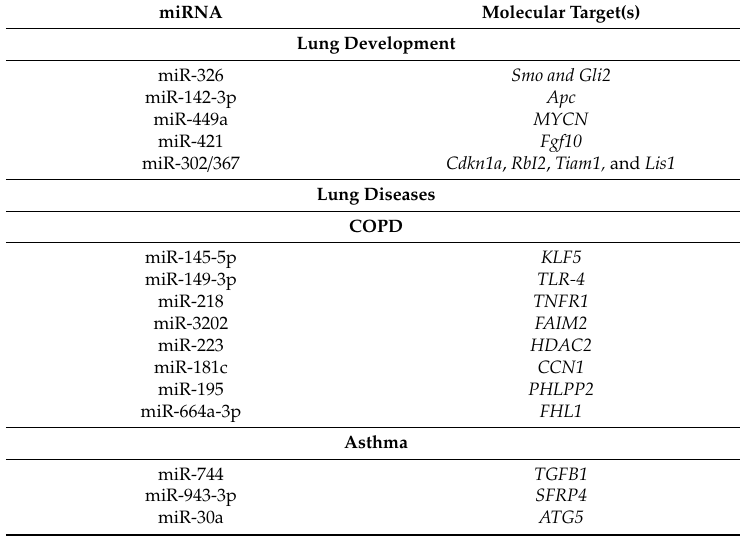
Figure 2. Schematic representation of miRNAs in pulmonary diseases as already cited from published articles. Arrows pointing downwards indicate the inhibition of the pathogenesis of the diseases by the miRNAs in the column. miRNAs in columns with arrows pointing upwards progress the development of the diseases. No miRNA was found to be involved in the progression of pulmonary fibrosis in this review. Table 1. miRNAs and their target genes in lung development and diseases, as shown in cited